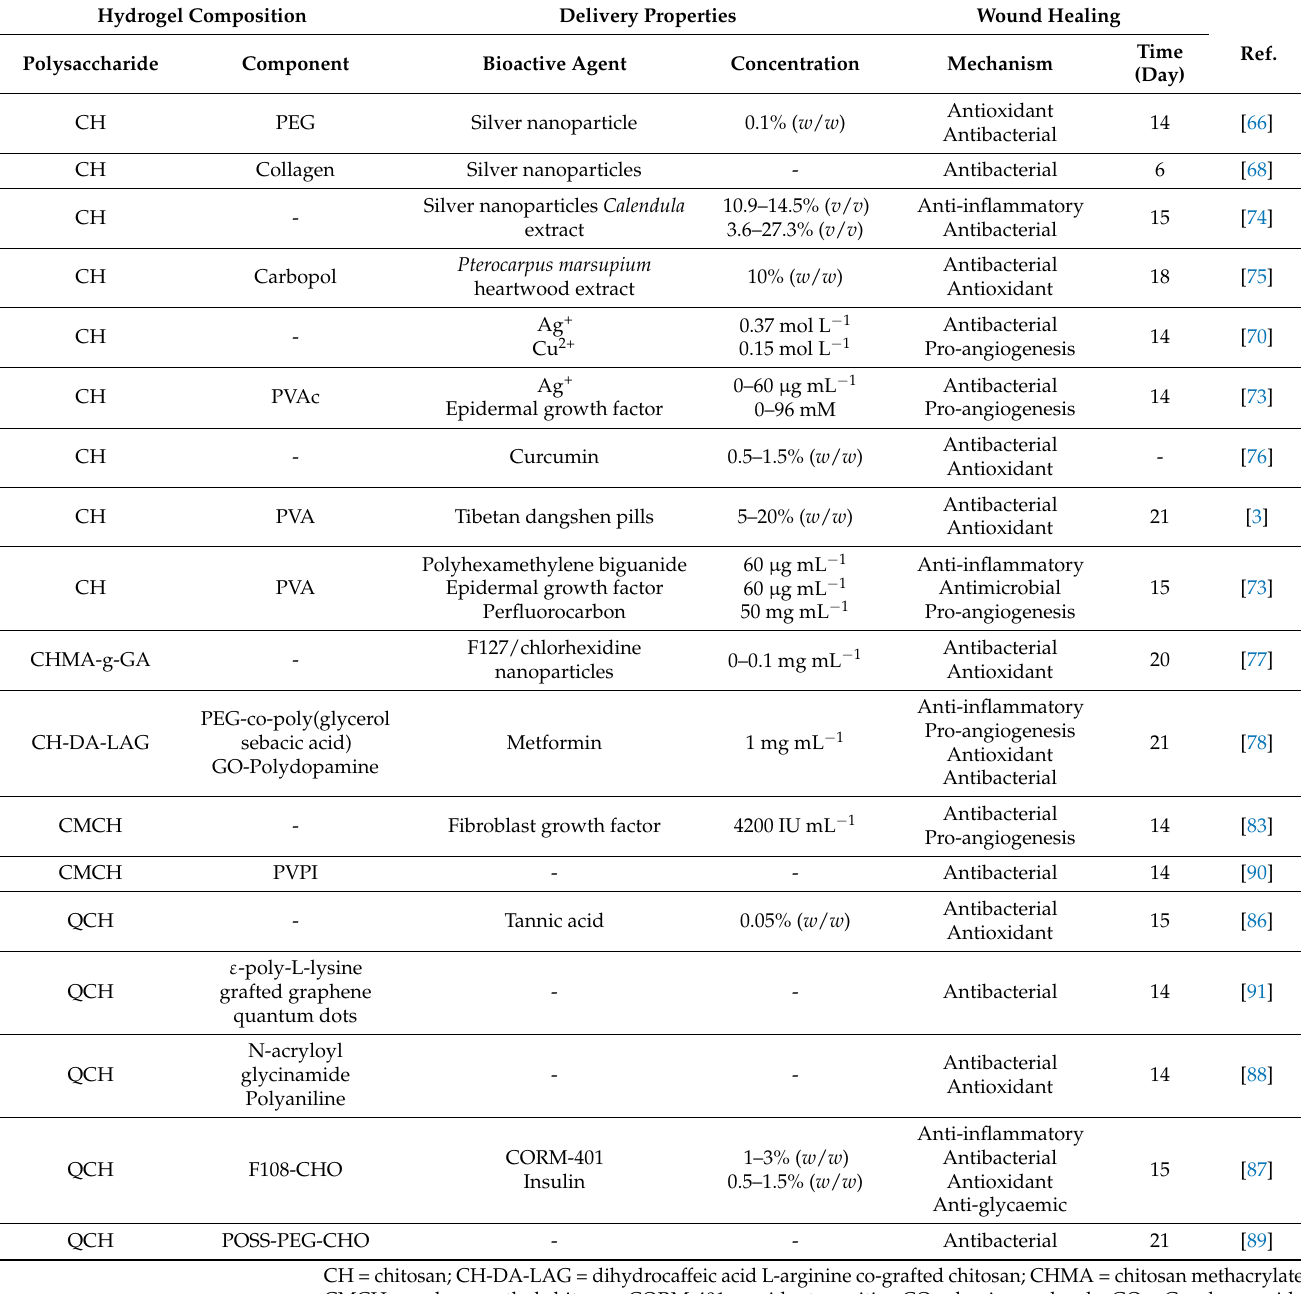
Table 5. Antibacterial CH-based hydrogels employed in the diabetic wound